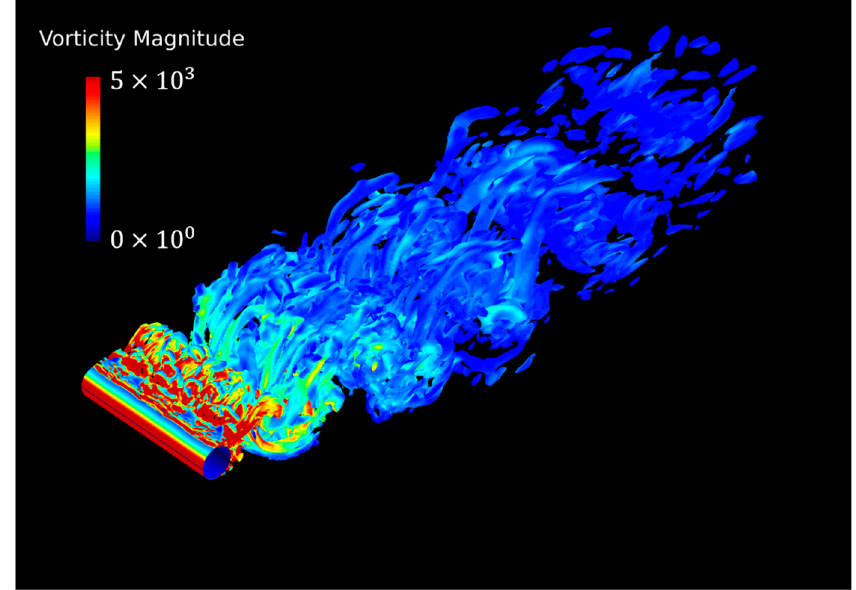
Figure 9. Normalized instantaneous spanwise vorticity ω(cid:3557) (cid:2936) = ω (cid:2936) /(U (cid:2998) D) ( a ) Simulation, ( b ) Experiment.